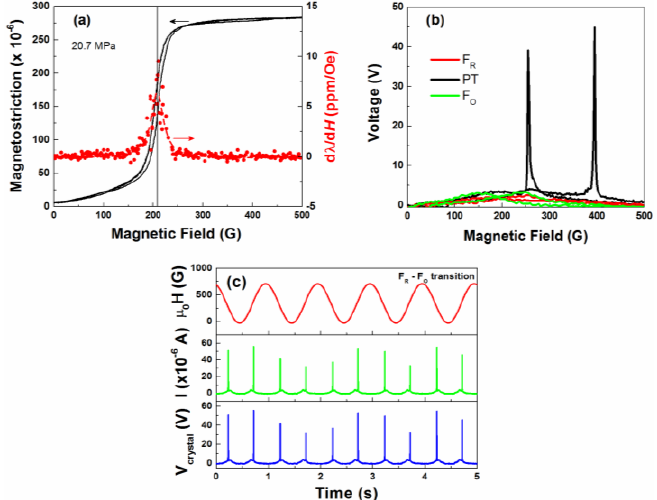
Figure 3. ( a ) Strain vs. applied magnetic field and d λ /d H for a stress-annealed Galfenol (Fe 81.6 Ga 18.4 ) rod with 20.7 MPa of compressive pre-stress applied. The vertical line denotes a typical magnetic bias point. ( b ) Voltage generated by the piezocrystal under the three different pre-stress conditions described in the text. ( c ) Time dependence of the applied magnetic field, induced current and voltage from the crystal (V crystal ) in the PT region while driving with an ac magnetic field (setup shown in Figure 2b).